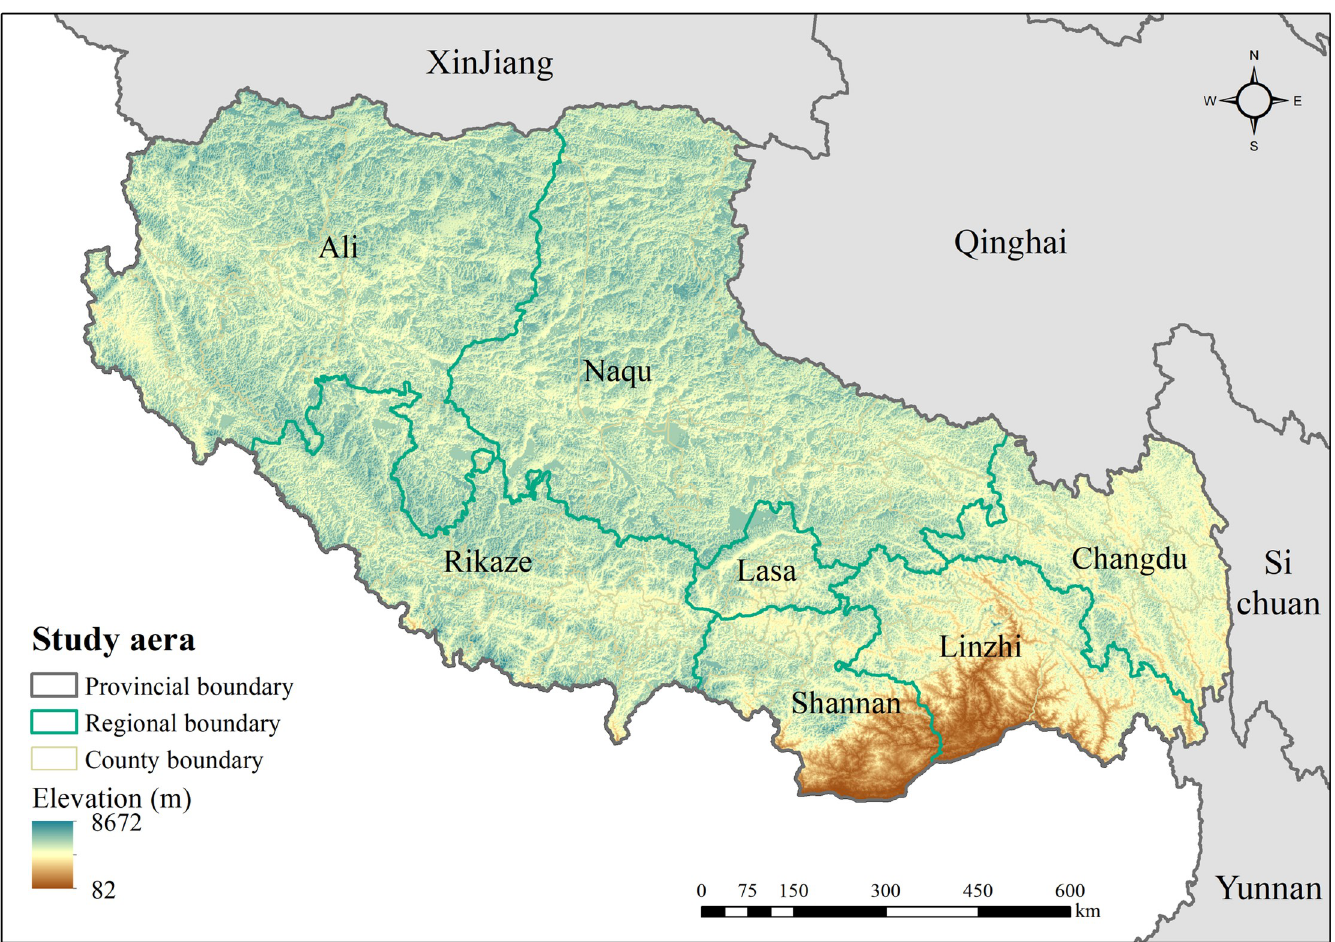
Fig 1. Study area—The Tibet Autonomous Region (Tibet) of the People’s Republic of China. Source of map: https://www.worldofmaps.net/typo3temp/images/ chinakarte.jpg.